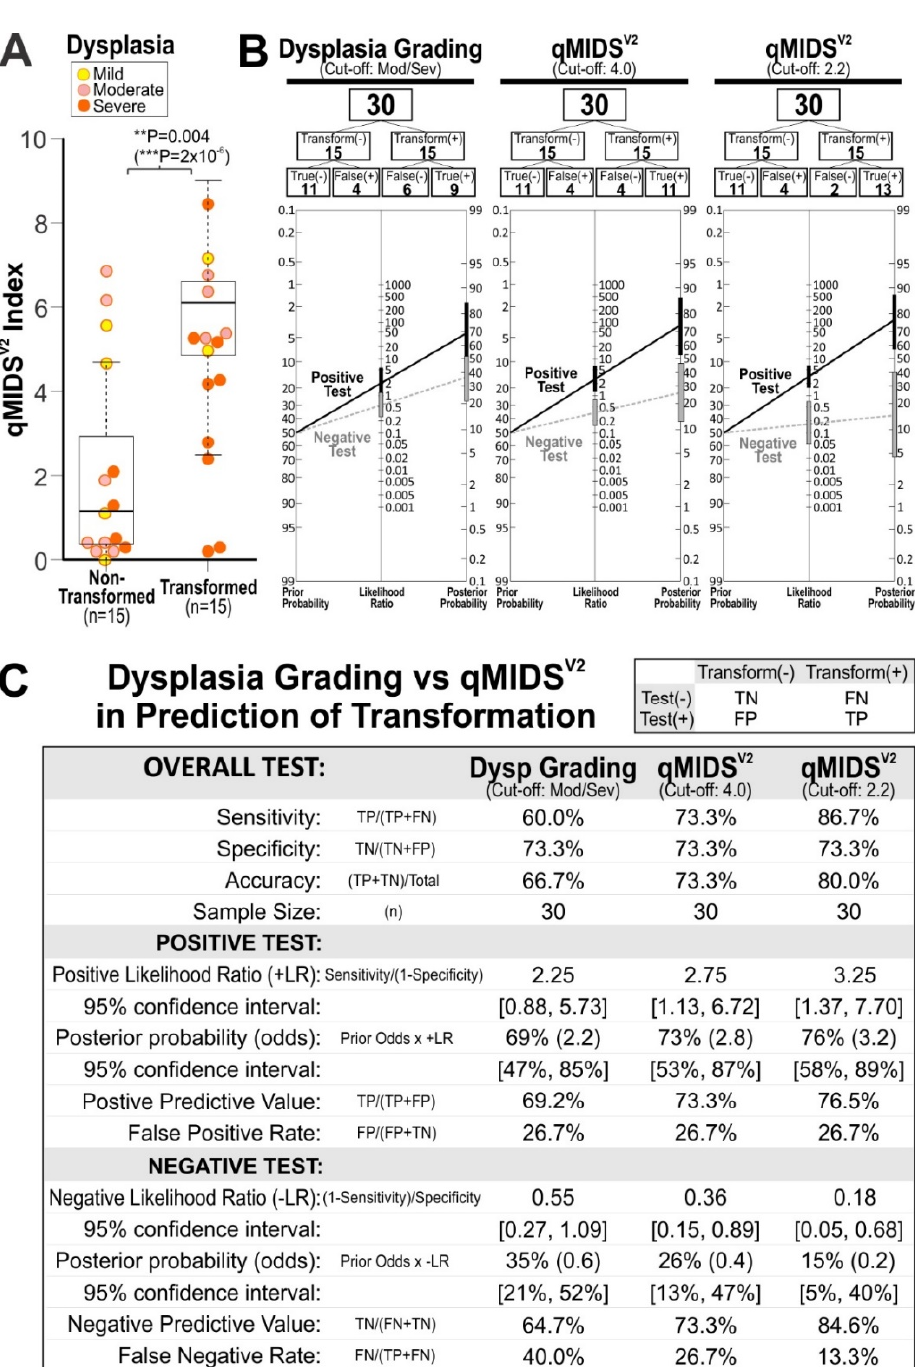
Figure 5. Comparison between pathological dysplasia grading method (WHO OED 2017) and qMIDS V2 for predicting malignant transformation in an Indian dysplasia cohort. ( A ), Dysplasia patients with 5-year outcome data ( n = 30 from Figure 4B) were re-grouped according to their dysplasia transformation status: non-transformed or transformed into OSCC within 5 years. Student’s t -test p < 0.004 and Mann–Whitney U-test ( p < 2 × 10 − 6 ) were performed due to skewed data distribution. Outliers are indicated by black outlined symbols and t -test p -values are indicated above the chart. ( B ), Prognostic performance of dysplasia grading (cut-off between mild/moderate and severe dysplasia grades) and qMIDS V2 (at cut-off 4.0 and 2.2) were analysed on the dysplasia cohort ( n = 30) from ( A ) and their respective prognostic efficiencies are tabulated in ( C ). TN, true negative; FN, false negative; FP, false positive; TP, true